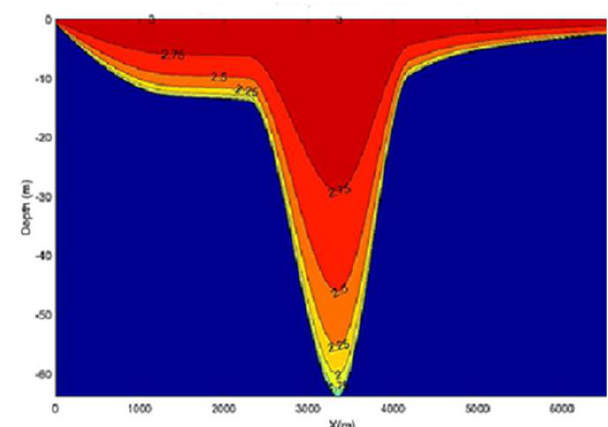
Fig. 10. Available lateral space for turbine installation. The two vertical lines represent the lateral limits of the considered area. (The circles represent points in which depth data are available, while the rest of the depth profile is obtained only by spline interpolation and is not accurately